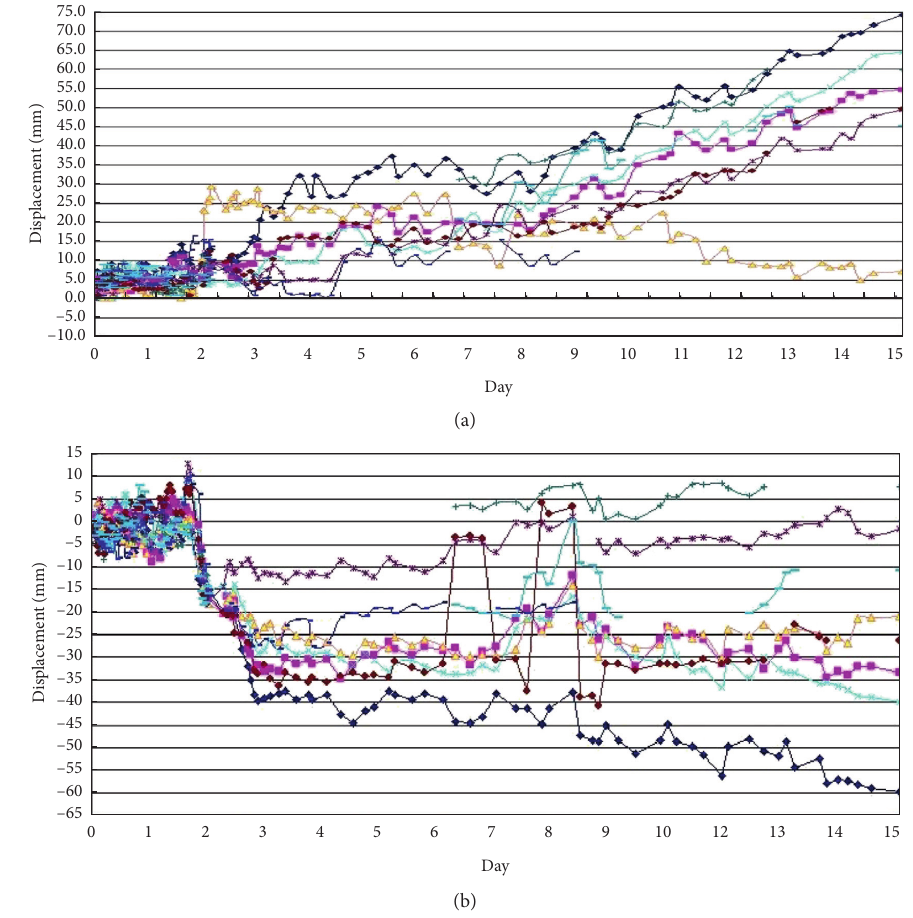
Figure 12: The cumulative displacement of monitoring points. (a) Cumulative horizontal displacement. (b) Cumulative vertical displacement.